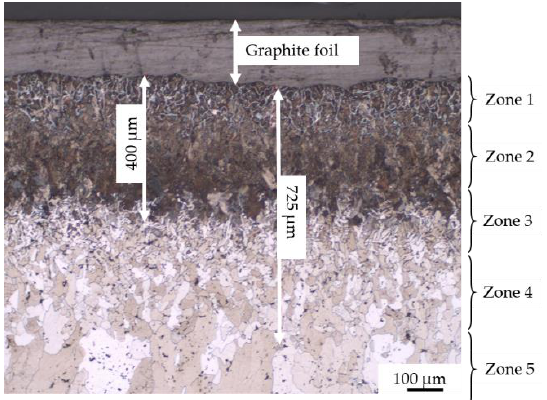
Figure 2. OM view of the top of the iron sample sintered using graphite foils without coating. A carburization zone of about 400 µm depth formed at the surface of the sample, in direct contact with the graphite foil. Five zones can be distinguished moving from the sample surface to the bulk (up to about 720 µm depth), as indicated in Figure 2. A magnification of zone 1 is presented in Figure 3.